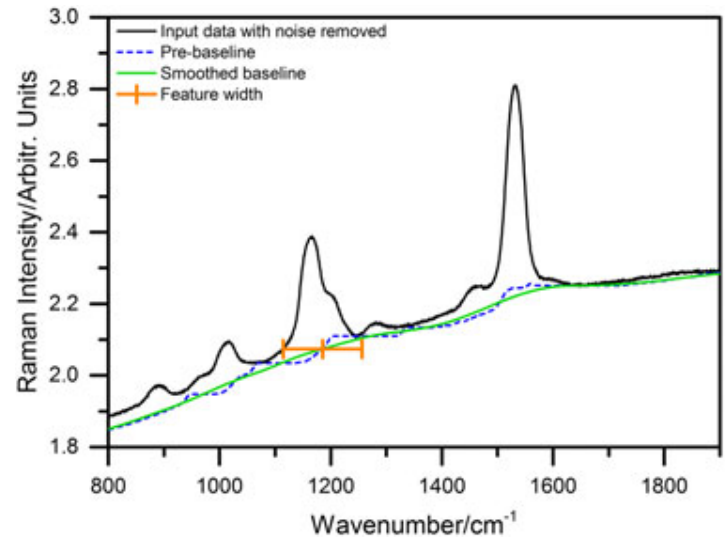
Figure 3. Smoothed measured Raman spectrum with corresponding feature width and the resulting pre-baseline. Smoothing the pre-baseline gives a (first) approximation of the true baseline. The smoothed baseline is subtracted from the unsmoothed measured spectrum completing the first iteration step (reproduced with permission from [45]).